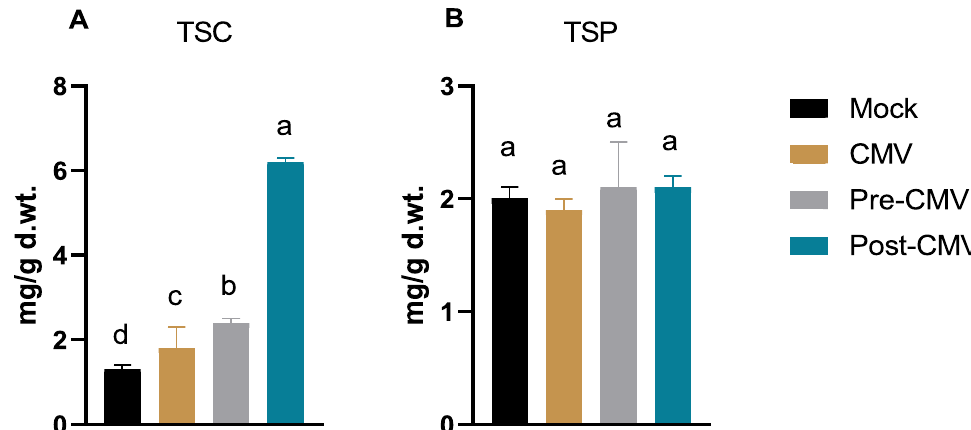
Figure 6. The impact of Ag-NPs foliar application upon ( A ) total soluble carbohydrate (TSC) and ( B ) total soluble protein (TSP) contents in squash plants. Mock: plants inoculated with viral inoculation buffer; CMV: plants mechanically inoculated with CMV; Pre-CMV: plants treated with Ag-NPs, 24 h before CMV inoculation; Post-CMV: plants treated with Ag-NPs, 24 h after CMV inoculation. Statistically, there is no variation between the means of the columns that share the same